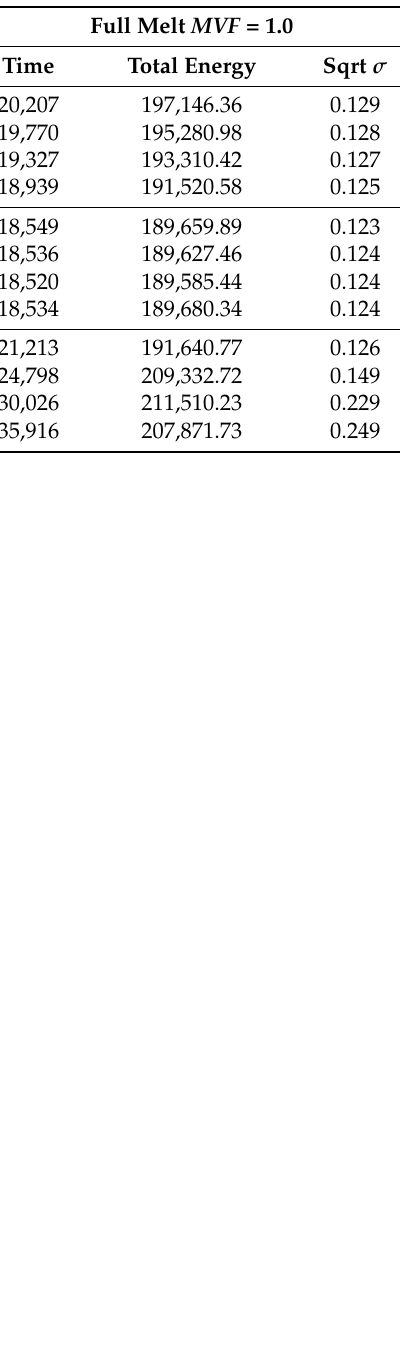
Table 8. Further investigation on the impact of design parameters around the optimum point for GO.